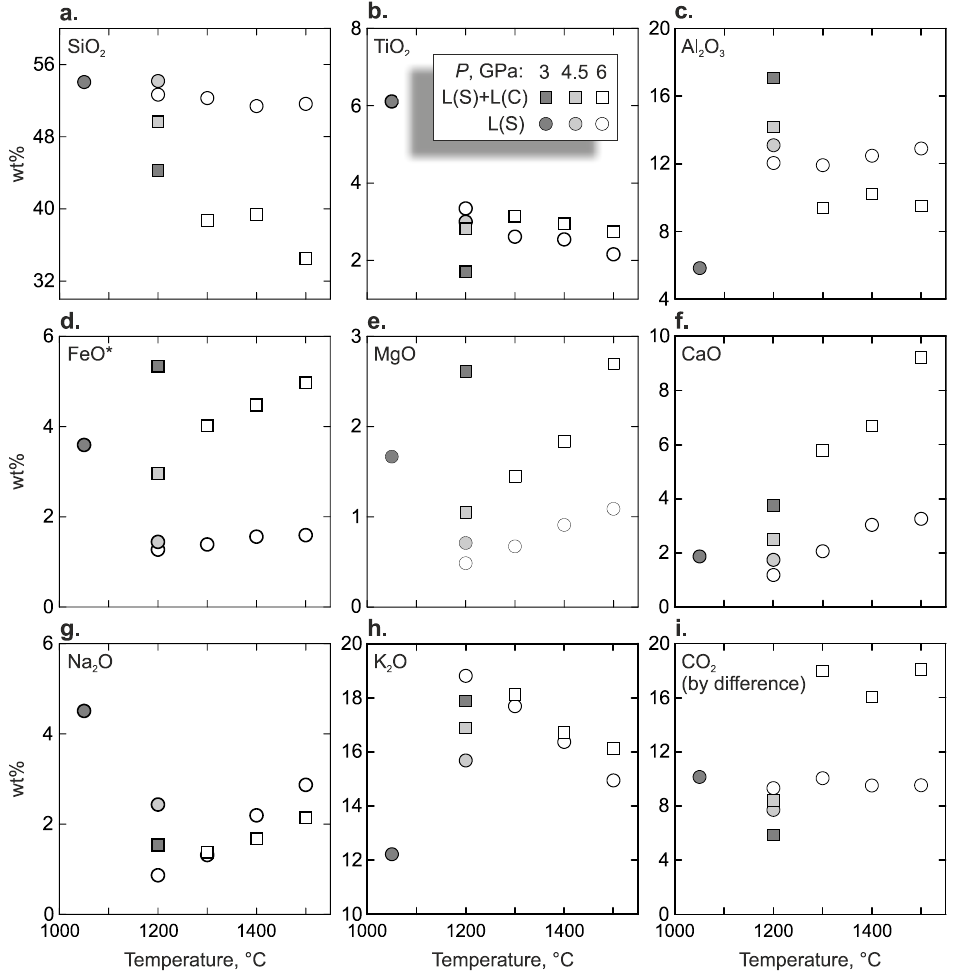
Figure 15. Compositions of silicate melt versus temperature. ( a ) SiO 2 , ( b ) TiO 2 , ( c ) Al 2 O 3 , ( d ) FeO, ( e ) MgO, ( f ) CaO, ( g ) Na 2 O, ( h ) K 2 O, ( i ) CO 2 . The volatile-bearing compositions normalized to 100%. FeO* = total Fe as Fe 2+ .